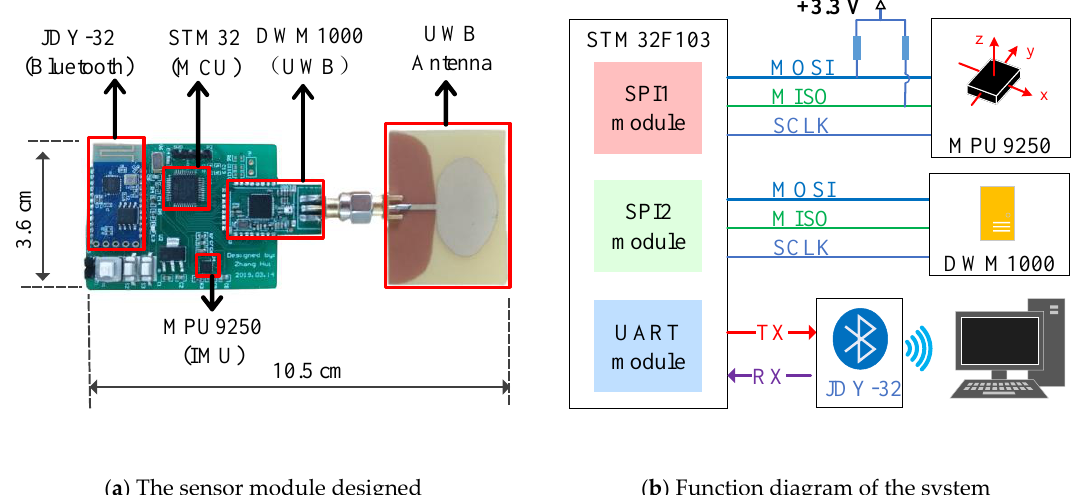
Figure 7. The UWB-IMU sensor module.